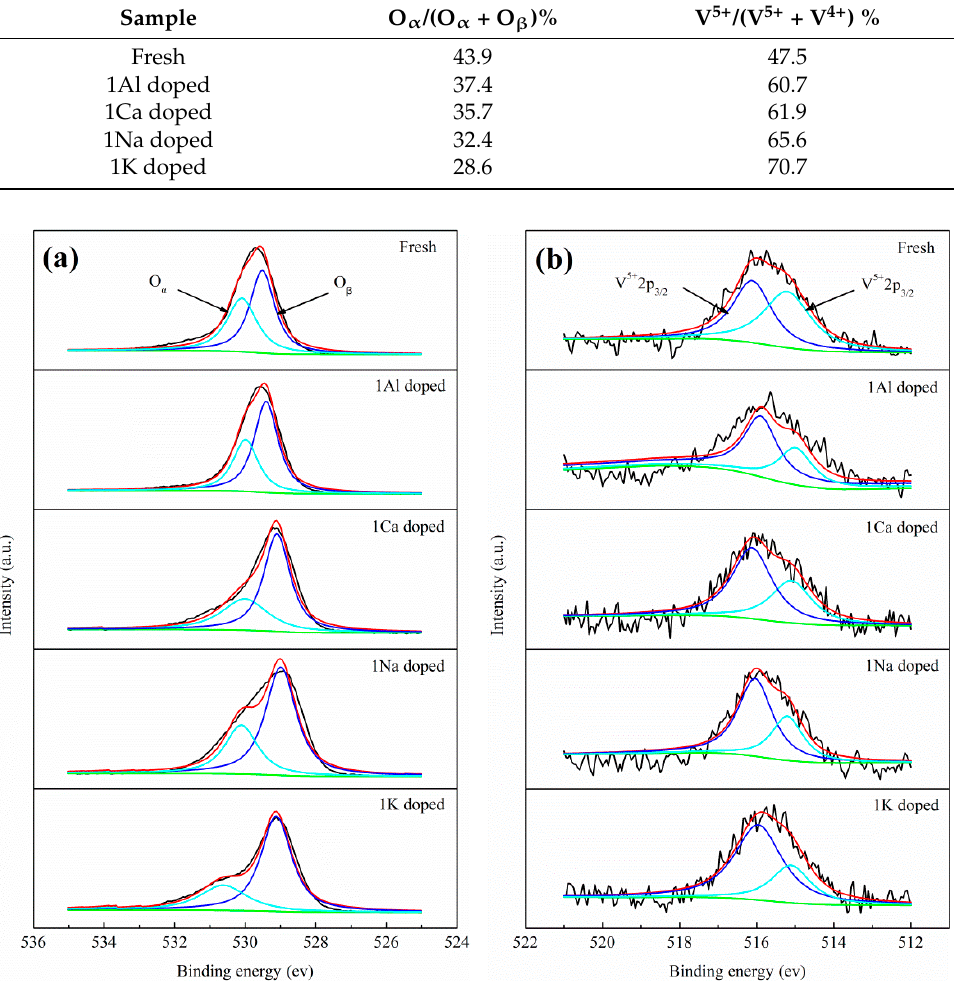
Figure 8. X-ray photoelectron spectroscopy (XPS) spectrum of O 1s ( a ) and V 2p ( b ) of fresh (1V-5W/Ti) and 1M doped catalysts (M = Al, Ca, Na, and K).